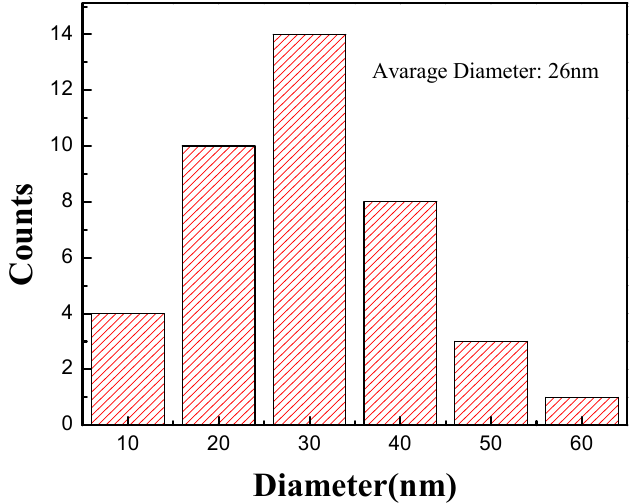
Figure 3. The diameter distribution of the vertically-aligned CNTs grown at 450 °C.